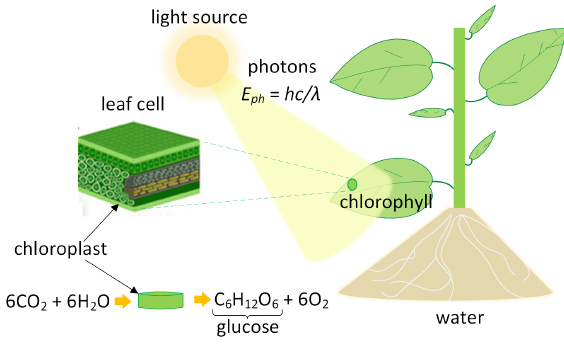
Fig. 2. Diagram of the photosynthesis process in plants.